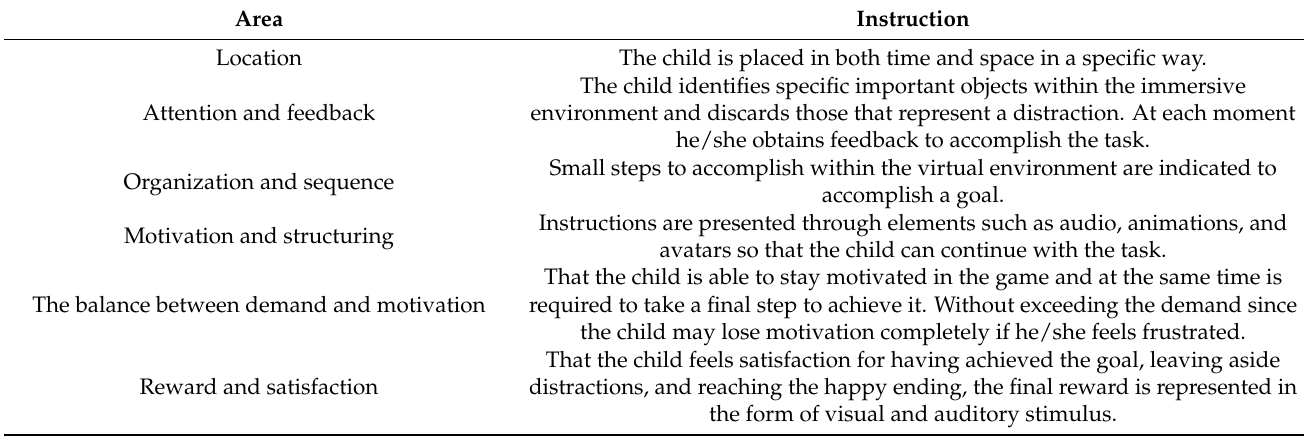
Table 2. Initial instructional design for the Attention-VR virtual reality environment.